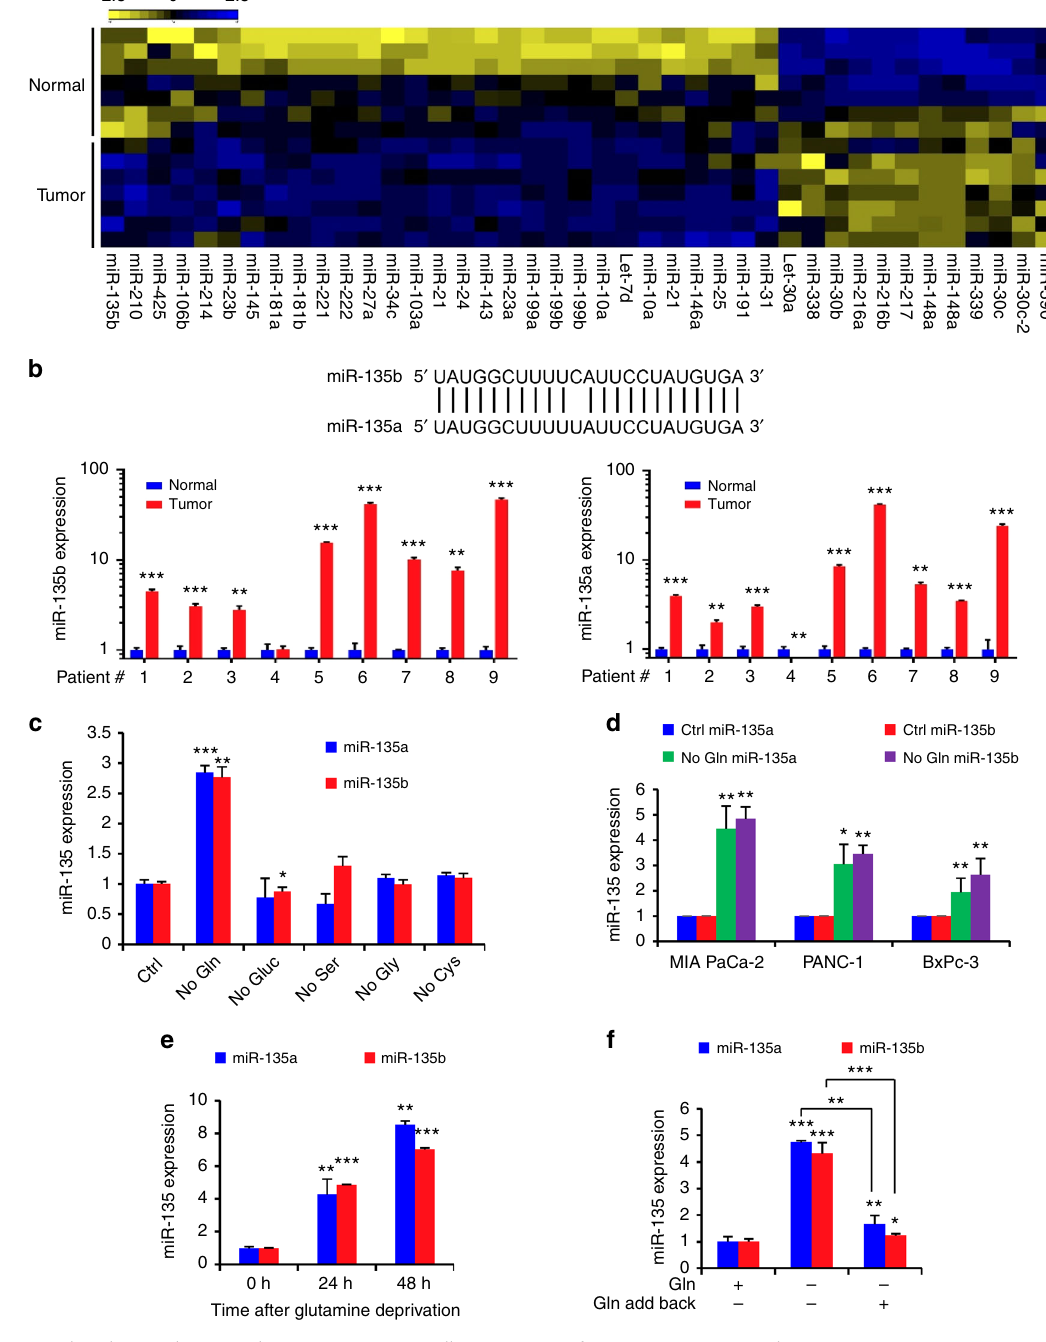
Fig. 1 miR-135 is induced upon glutamine deprivation in PDAC cells. a Heatmap of miRNAs expression in human pancreatic tumors compared with normal tissues measured by RNA-seq. b Alignment between mature miR-135b and miR-135a indicating one nucleotide difference; miR-135b and miR-135a expression in nine pairs of pancreatic tumors compared with adjacent normal tissues were measured by qPCR. Each value represents the mean ± SD in three independent experiments. ** p < 0.01, *** p < 0.001, Student ’ s t test. c MIA PaCa-2 cells were cultured in medium without glutamine, glucose, serine, glycine or cysteine for 24 h. miR-135a and miR-135b relative expression were assessed by qPCR. Each value represents the mean ± SD in three independent experiments. * p < 0.05, ** p < 0.01, *** p < 0.001, Student ’ s t test. d MIA PaCa-2, PANC-1, and BxPc-3 cells were cultured in glutamine-free medium for 24 h. miR-135a and miR-135b relative expression were assessed by qPCR. Each value represents the mean ± SD in three independent experiments. * p < 0.05, ** p < 0.01, Student ’ s t test. e MIA PaCa-2 cells were cultured in glutamine-free medium for 24 or 48 h. miR-135 expression was assessed by qPCR. Each value represents the mean ± SD in three independent experiments. ** p < 0.01, *** p < 0.001, Student ’ s t test. f MIA PaCa-2 cells were cultured in glutamine-free medium for 24h, then glutamine was added back, and cells were cultured an additional 24 h. miR-135a and miR-135b relative expression were assessed by qPCR. Each value represents the mean ± SD in three independent experiments. * p < 0.05, ** p < 0.01, *** p < 0.001, Student ’ s t test (Ctrl: complete medium; No Gln: glutamine-free medium). PDAC: pancreatic ductal